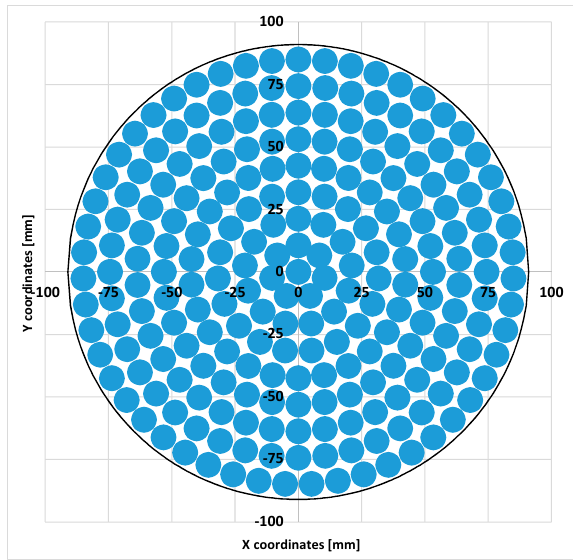
Figure 1. Measuring probe positions over the SCR outlet face.